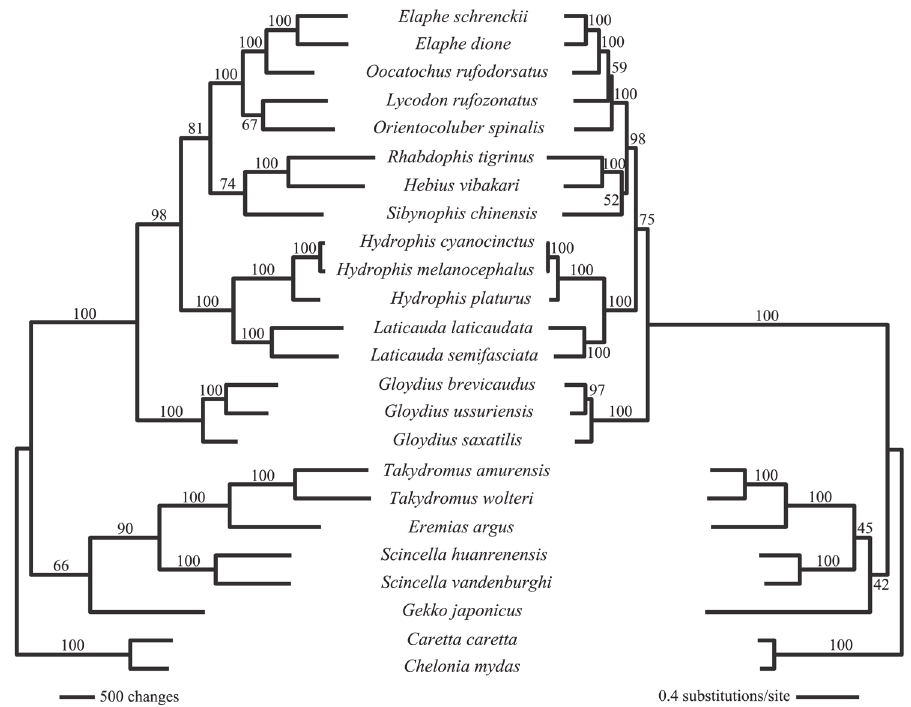
Figure 2. Maximum Parsimony (MP) tree (left) and Maximum Likelihood (ML) tree (right) for all 22 squa- mates listed in South Korea. Both MP and ML trees are based on 13 mitochondrial protein-coding genes. Caretta caretta and Chelonia mydas are outgroup species. Bootstrap values are denoted on each tree